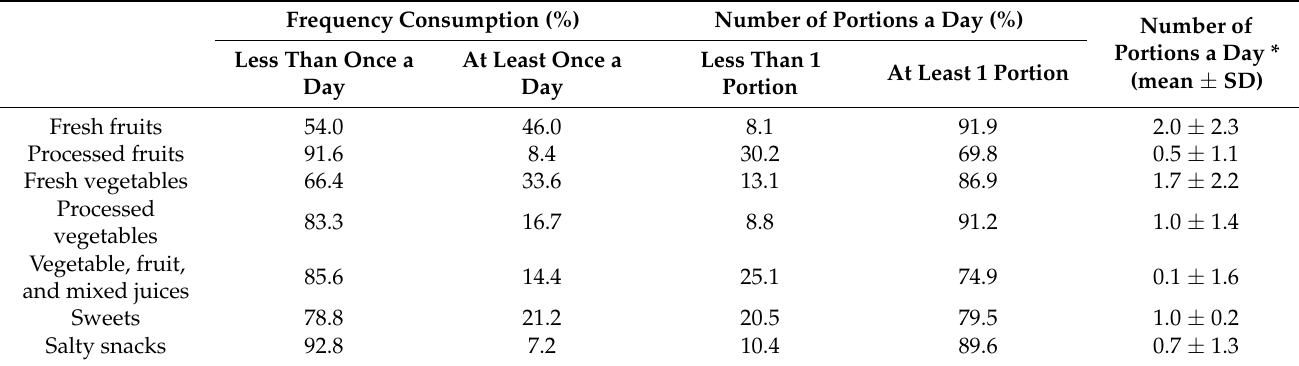
Table 4. Food consumption in the study sample.